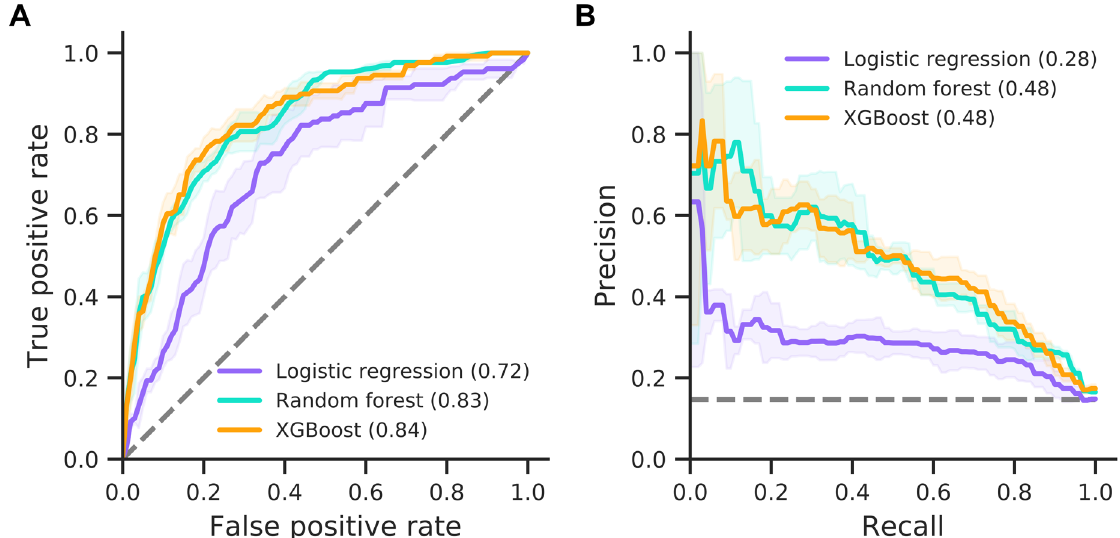
Figure 2. Prediction performance for AICU admission. Model performances for the logistic regression, random forest and XGBoost models are shown as ROC (A) and precision-recall curves (B). AUC is provided in brackets. Solid lines and shaded areas indicate the mean and standard deviation across three cross-validation folds, respectively. Dashed lines indicate random